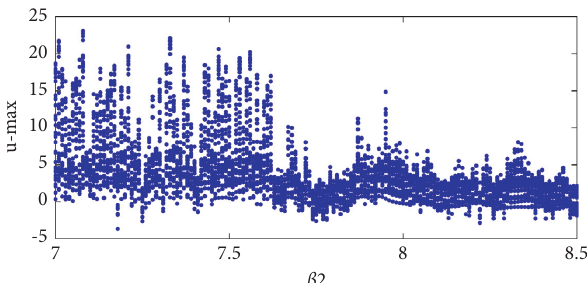
Figure 6: Bifurcation diagram system (25) for the parameter β